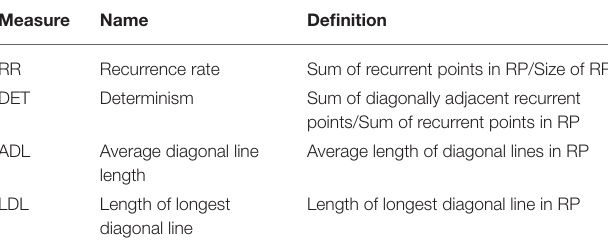
TABLE 2 | Values of the RQA measures RR, DET, ADL, and LDL for the recurrence plots shown in Figures 3H–K with embedding